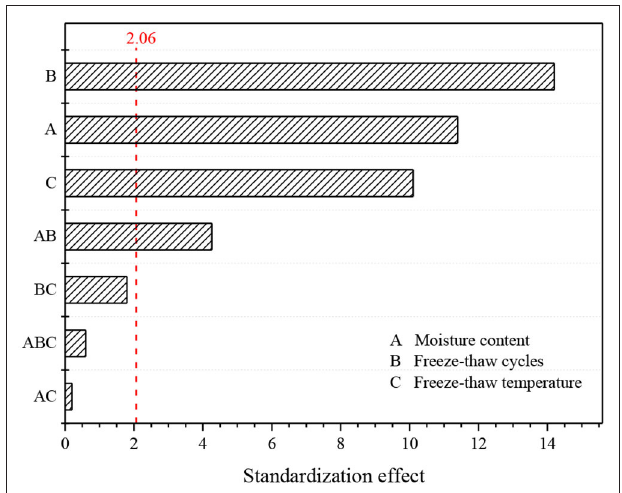
FIGURE 5 | Pareto diagram of standardization